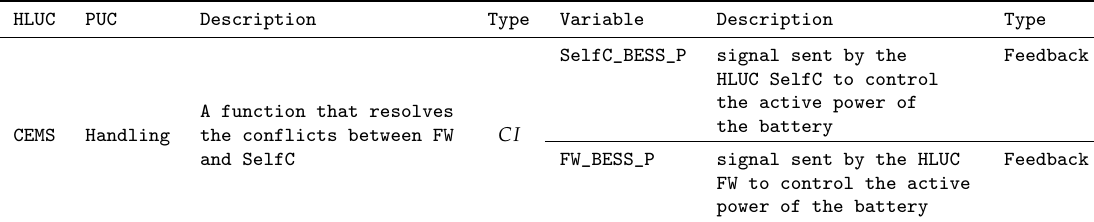
Table 17. PUC (Handling) to resolve C I and C V .